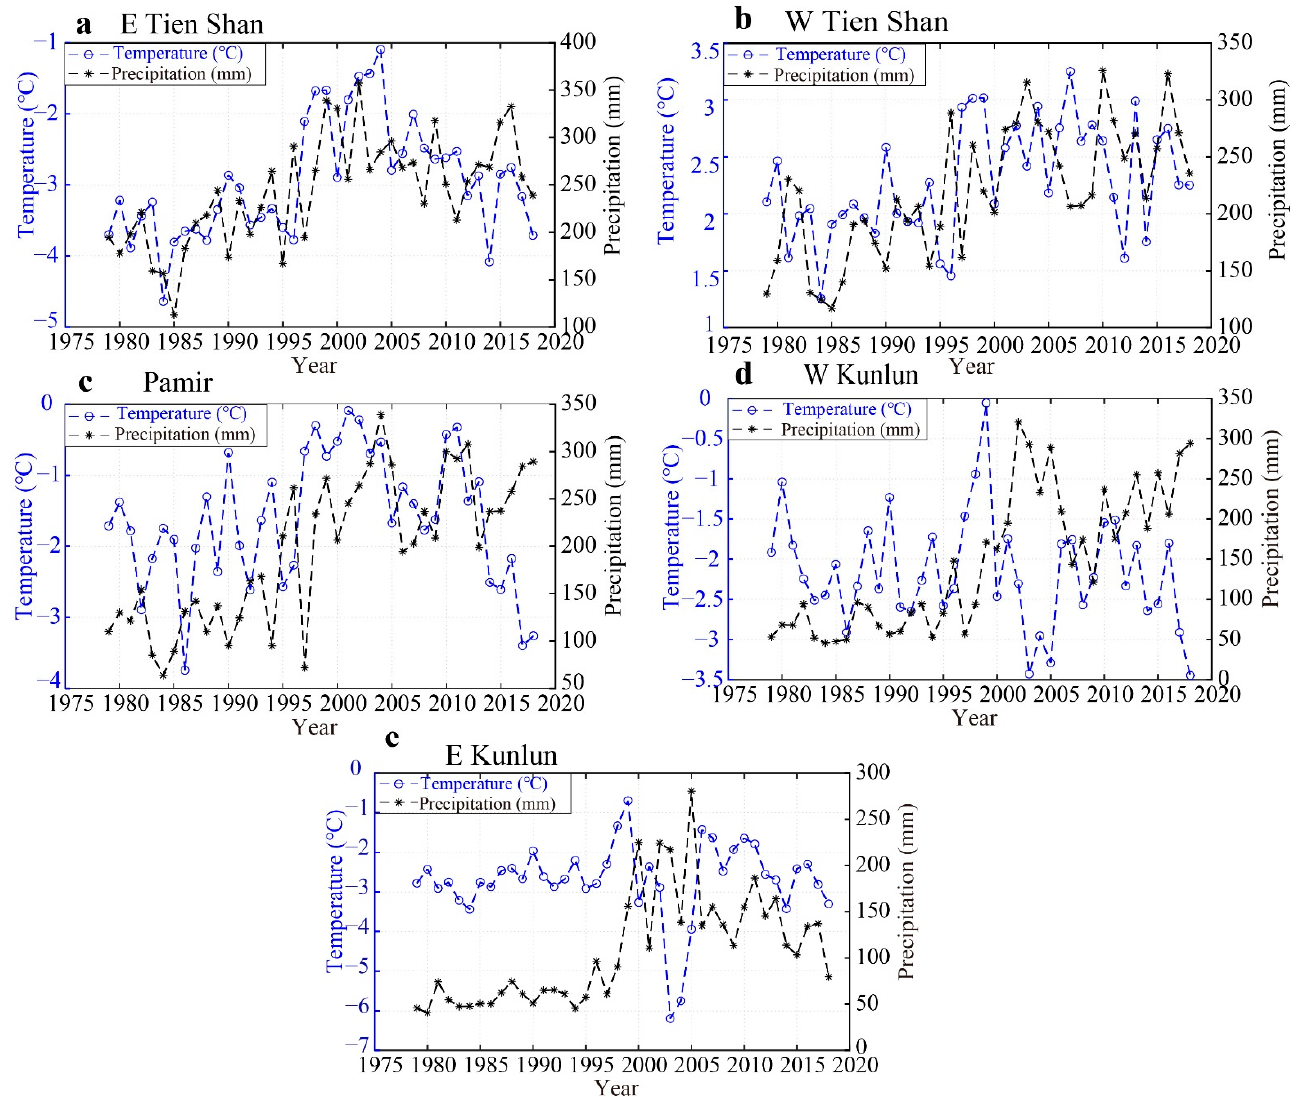
Figure 11. Time series of mean annual surface air temperatures and mean annual precipitation (1979–2018) database. Data acquired from the China Meteorological Forcing Dataset [67] .